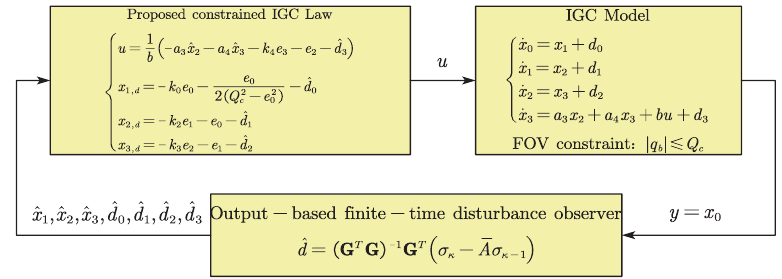
Figure 3. Schematic diagram of the proposed